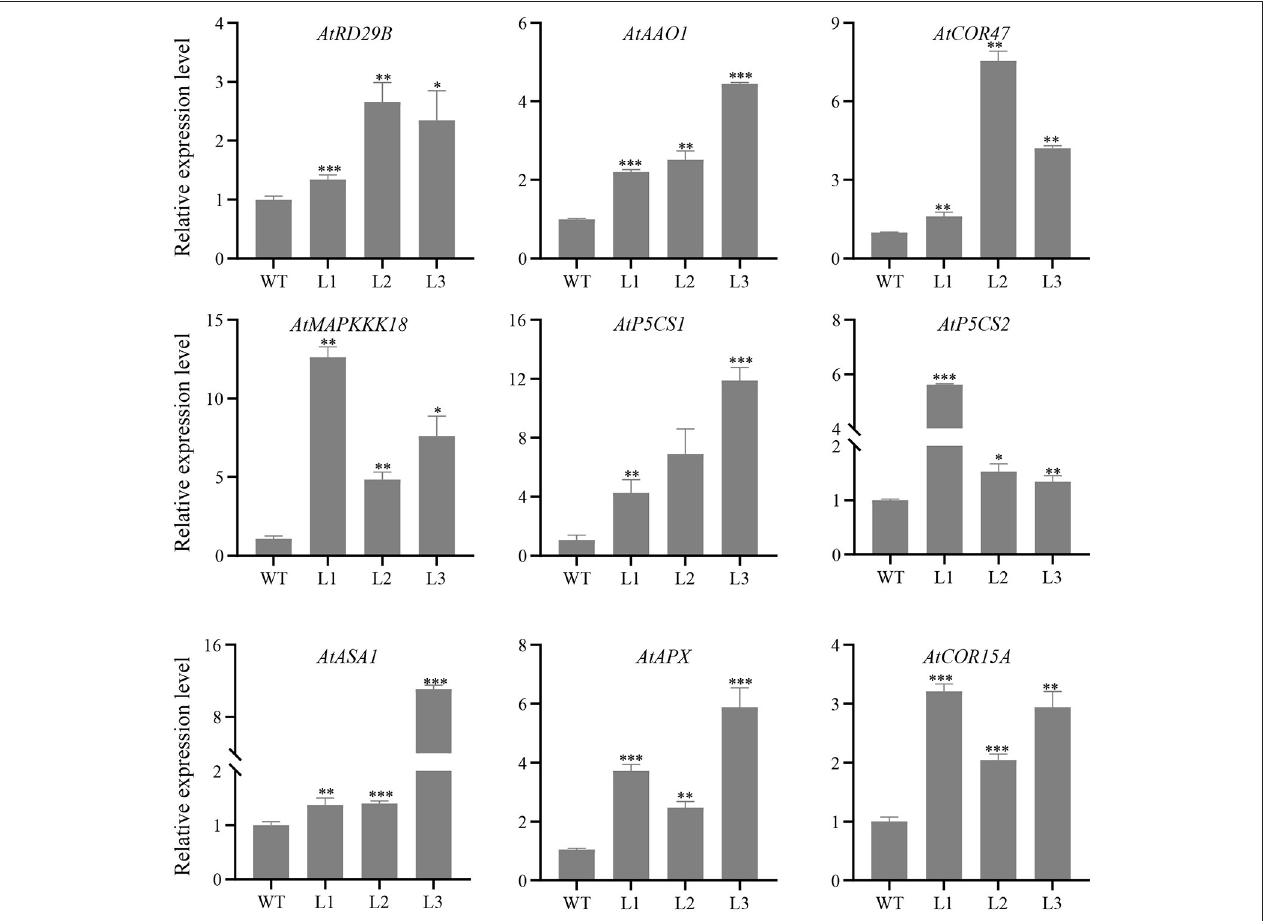
FIGURE 6 | Transcript levels of salt stress-related marker genes. Relative expression patterns of nine genes related to salt stress were examined by qRT-PCR in WT and GhERF13.12 overexpressing lines. The standard deviation among three biological replicates is shown by the error bars. * p < 0.05, ** p < 0.01, and *** p < 0.001 (Student’s t -test). WT, wild type; L1, L2, and L3, GhERF13.12 transgenic homozygous